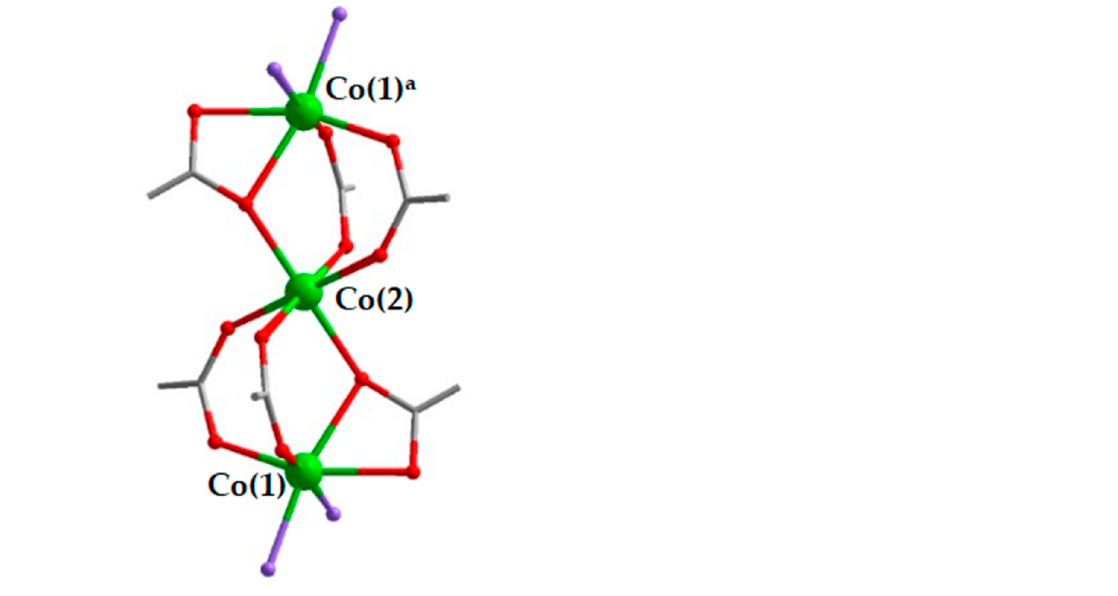
Figure 2 . Projection of the crystal structure of 1 along different directions. Cobalt atoms are shown by green balls. Only N atoms of coordinated bpy ligands are shown. Hydrogen atoms and guest solvent molecules are omitted.